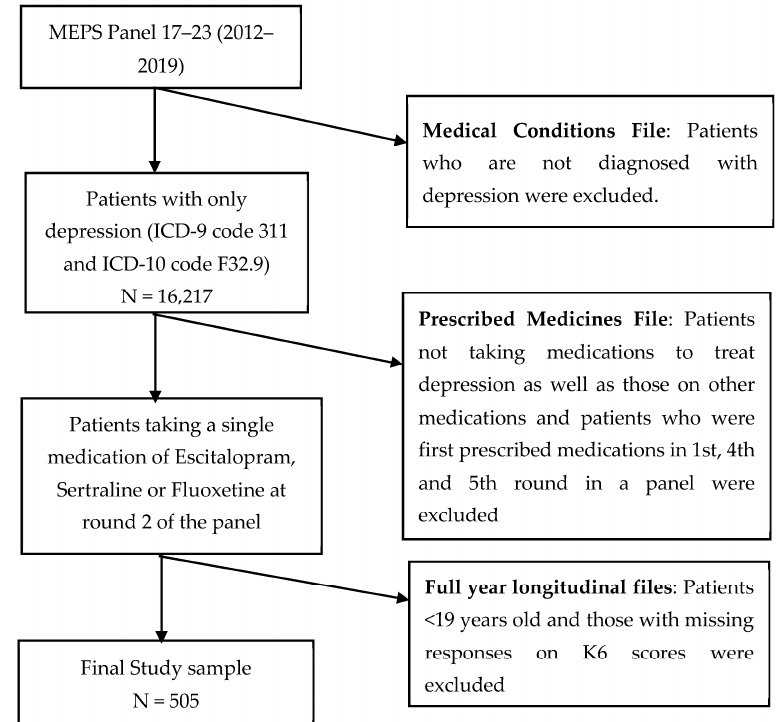
Figure 2. Flowchart of study cohort